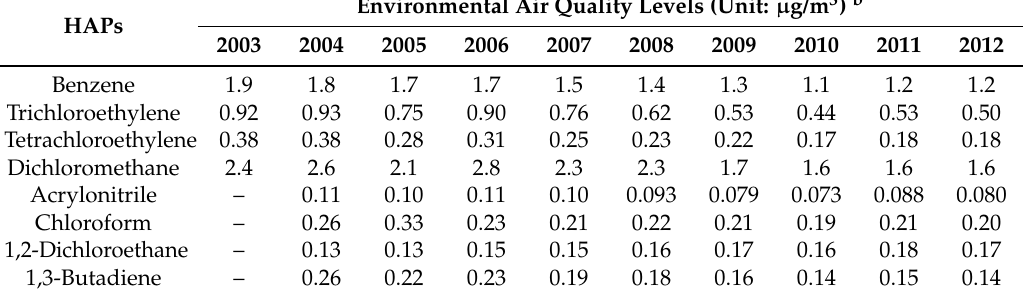
Table 4. Environmental monitoring levels for toxic VOCs in the atmosphere over the past 10